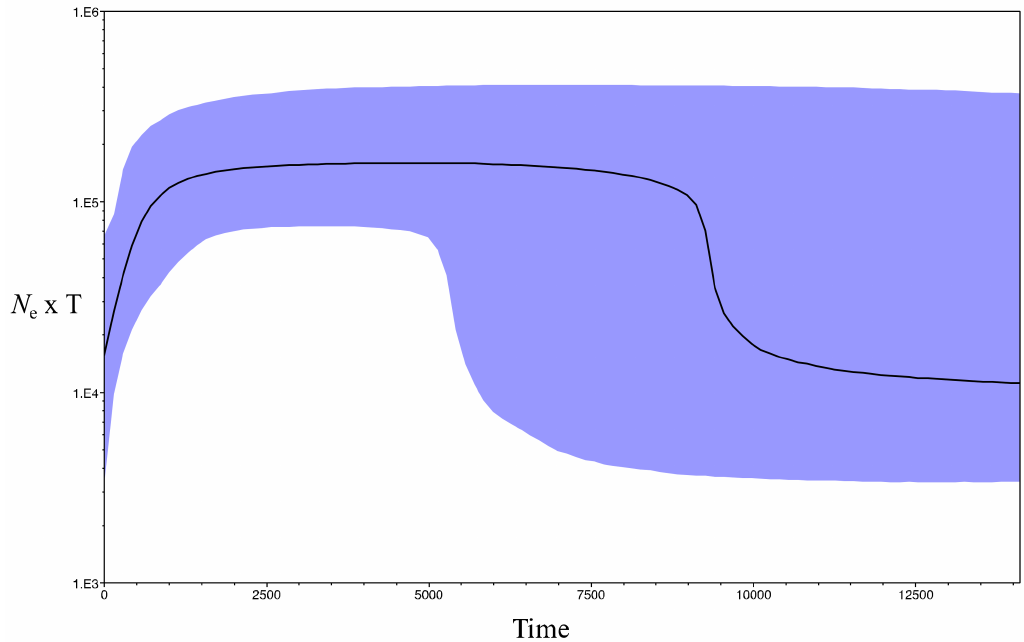
Figure 4. Bayesian Skyline plot (BSP) depicting population size change through time in k¯ak¯ap¯o for full mitogenomes (16,588 bp). Timing of events was estimated assuming a substitution rate of 1–3 × 10 − 8 site − 1 year − 1 [39]. The x axis is in calendar years before present and y axis equals changes in effective population size (shown as the product of N e and generation time T). The black line is the median estimate and the blue lines show the 95% highest posterior density